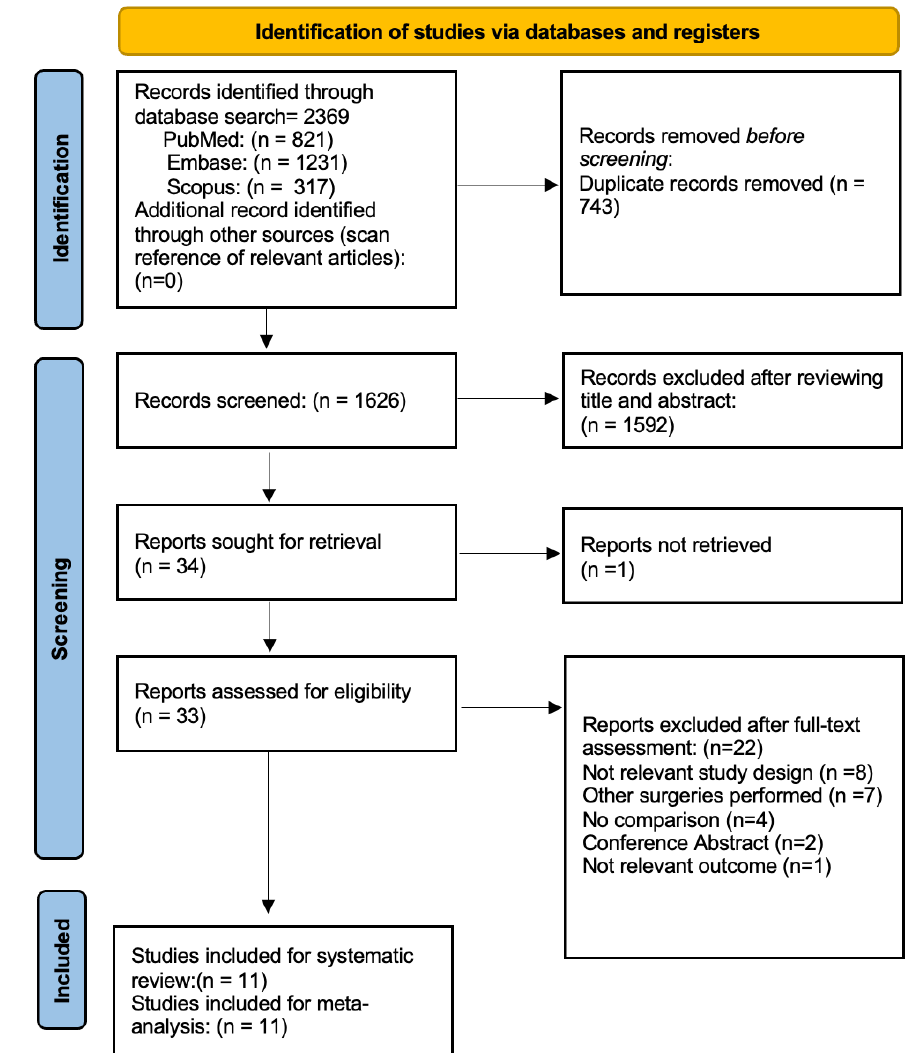
Figure 1. Flow Diagram of the Study Selection Process.